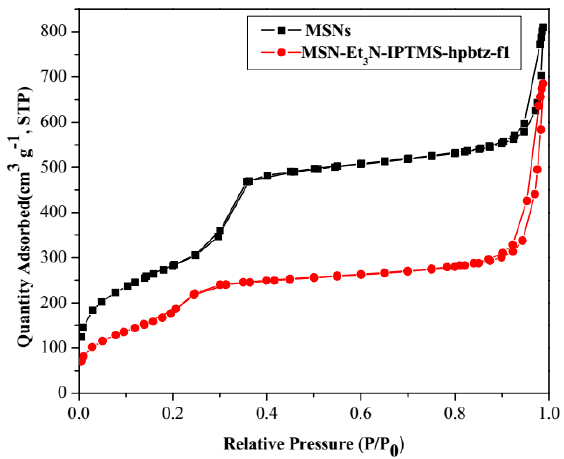
Figure 3. Nitrogen adsorption/desorption isotherms of MSNs and MSN-Et 3 N-IPTMS-hpbtz- f1 . For both materials, a mixture between type IV and type VI isotherms are exhibited.